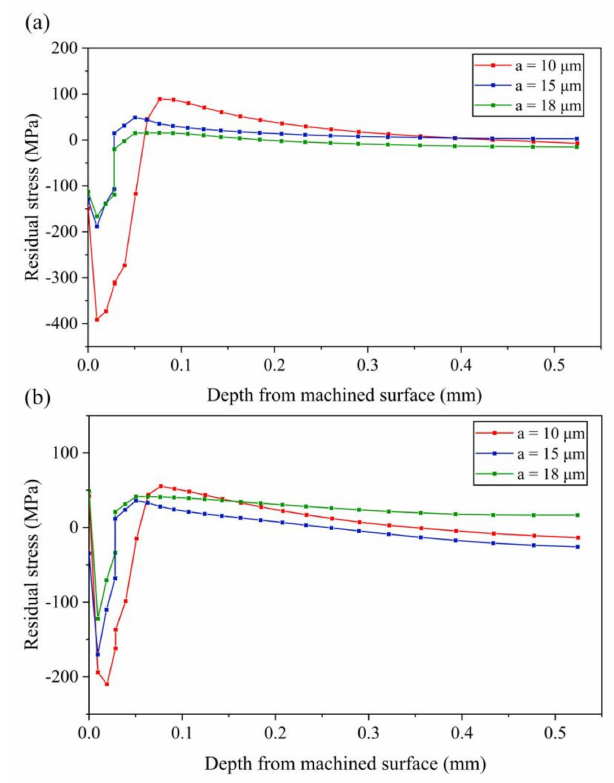
Figure 13. Results of residual stress with various amplitudes a ( a ) stress-xx ( b ) stress-zz.